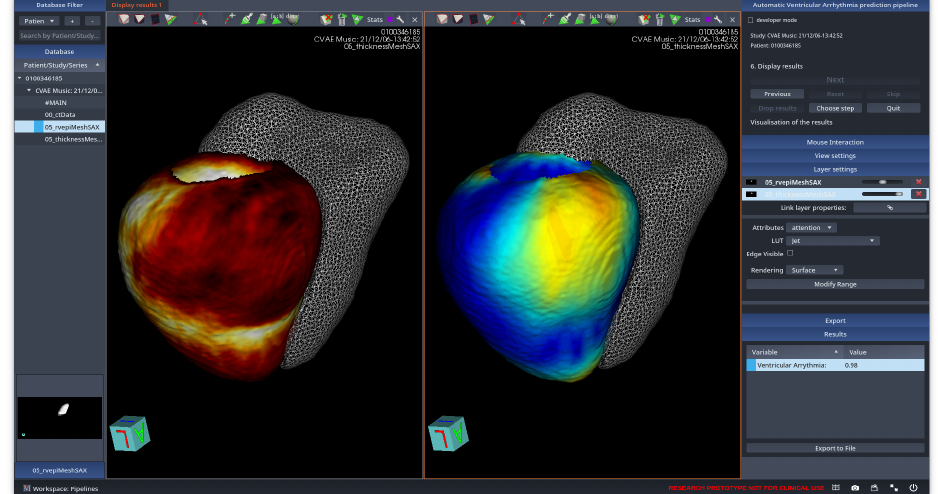
Figure 12. The output results at the end of the pipeline. The VA classification result is shown in the bottom right corner at 98%. The two views show the mesh of the LV wall thickness and classification attention map. The views could be linked together, showing that higher attention (red on left mesh) was placed within the thinning region of the LV (yellow/green on right mesh). The interactive side-by-side display of the thickness and attention map helps to explain the model prediction and increases the user’s confidence in the AI